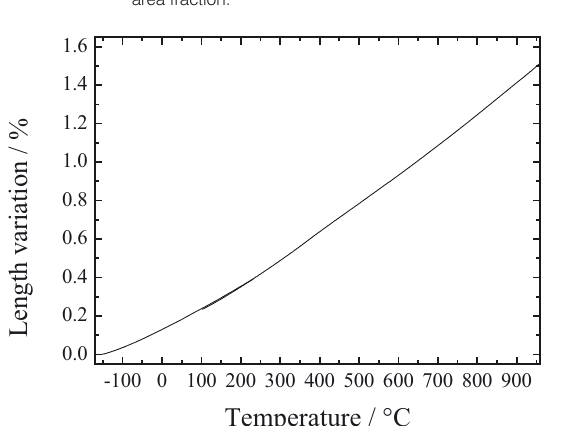
Figure 7. Electron backscattering diffractogram of a textured Ni tape annealed at 1000°C for 120 min in flowing Ar + 6.5% v/v H 2